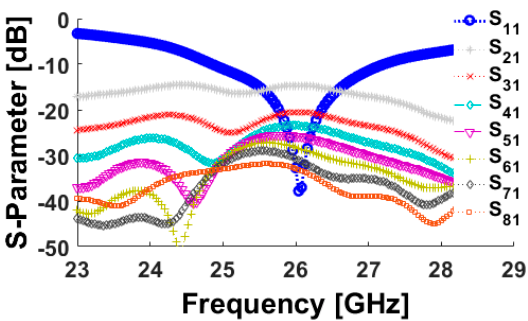
Figure 12. S parameter results of the mm-Wave 5G smartphone antenna.